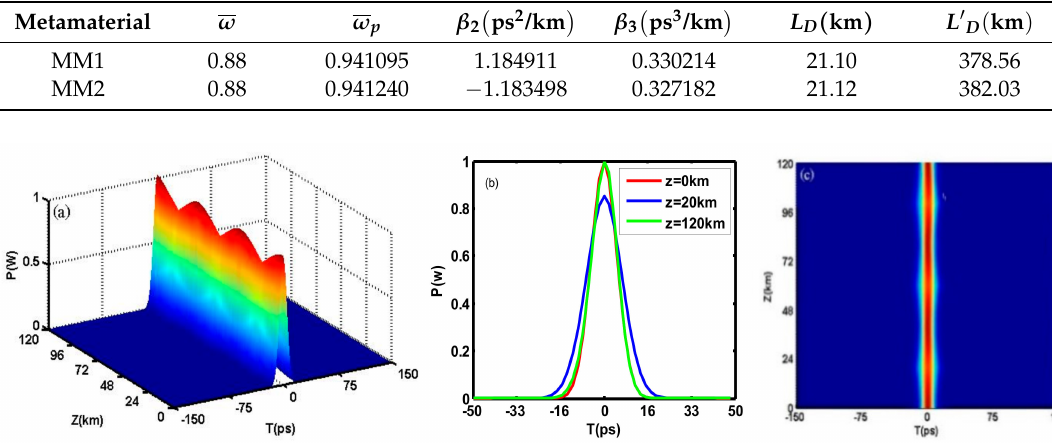
Figure 10. ( a ) Gaussian pulse’s 120 km propagation in MM1 and MM2; ( b ) waveforms of the Gaussian pulse; ( c ) top view of ( a